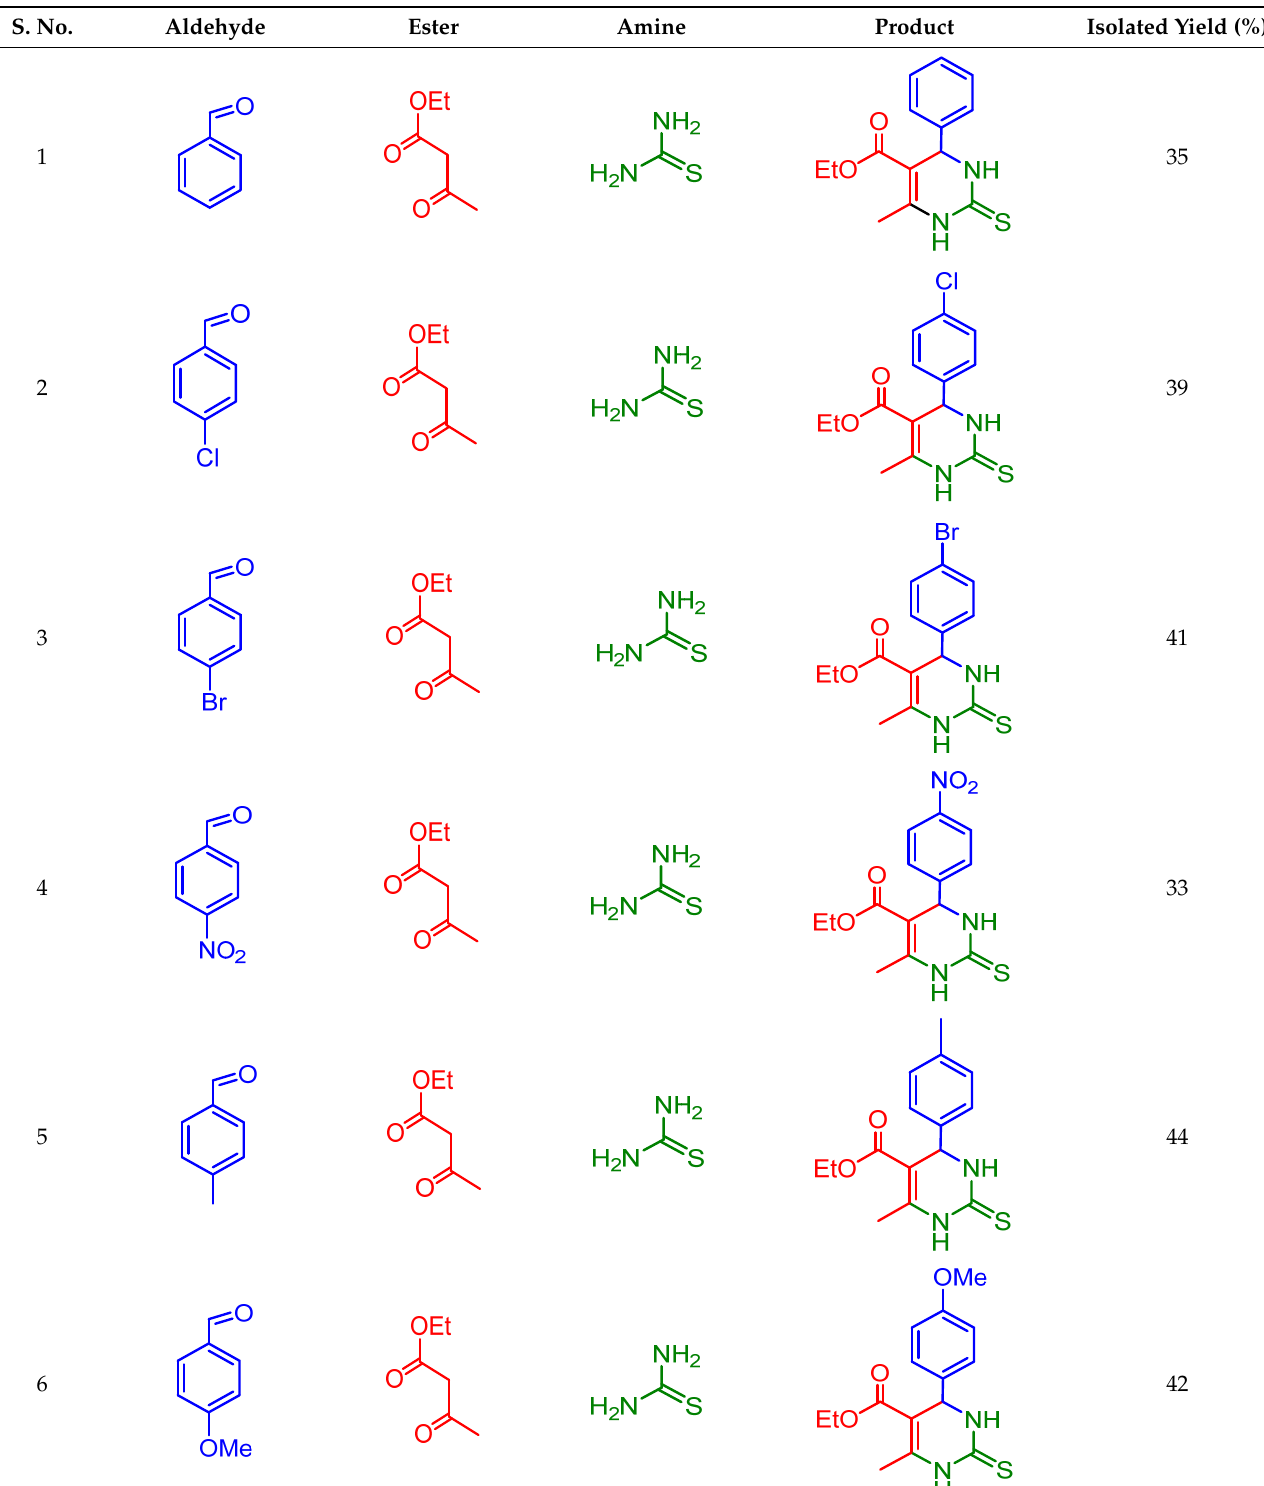
Table 4. Details for multicomponent Biginelli reaction for the synthesis of dihydropyrimidine-2- thione (reaction conditions: respective aldehyde (5 mmol), ethyl acetoacetate (5 mmol), thiourea (6 mmol), and catalyst 2 (0.015 g)) under solvent-free conditions at 80 ◦ C for 3 h of reaction